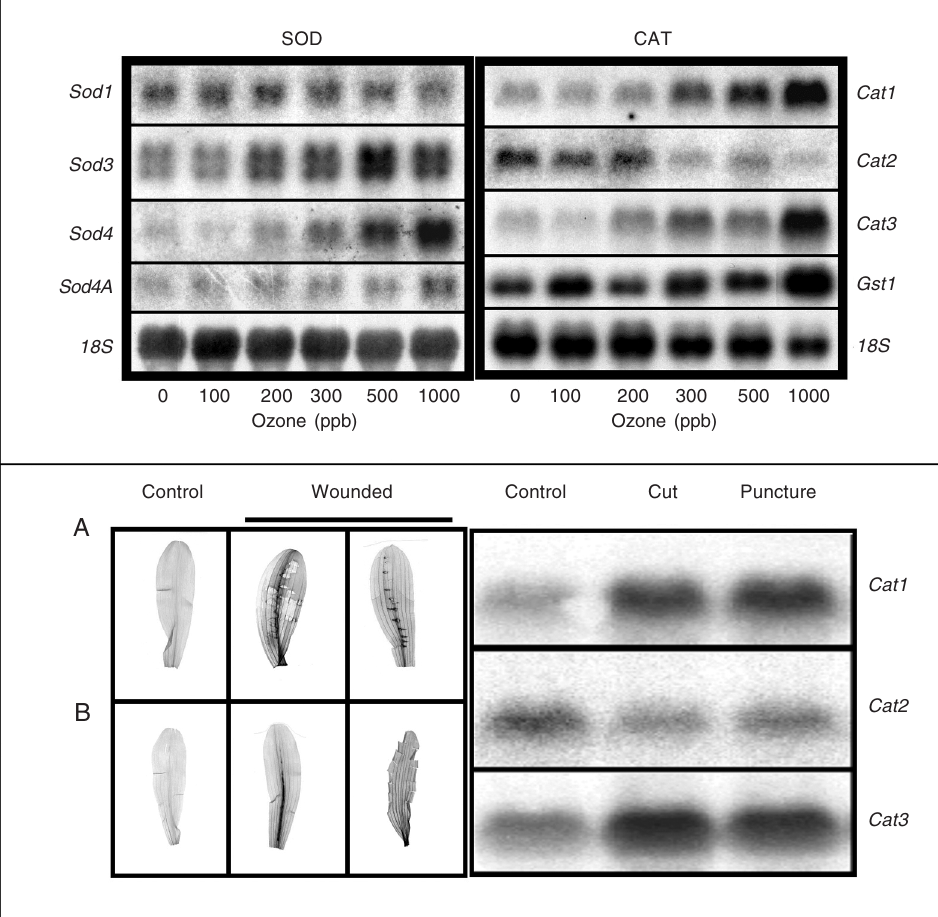
Figure 4. Response to acute ozone exposure of the Sod (top- left) and Cat (top-right) genes in maize leaves after 6 h of O 3 fu- migation. As noted, some of the transcripts are upregulated (e.g., Sod3 , Sod4 , Cat1 , Cat3 ), while others are downregulated